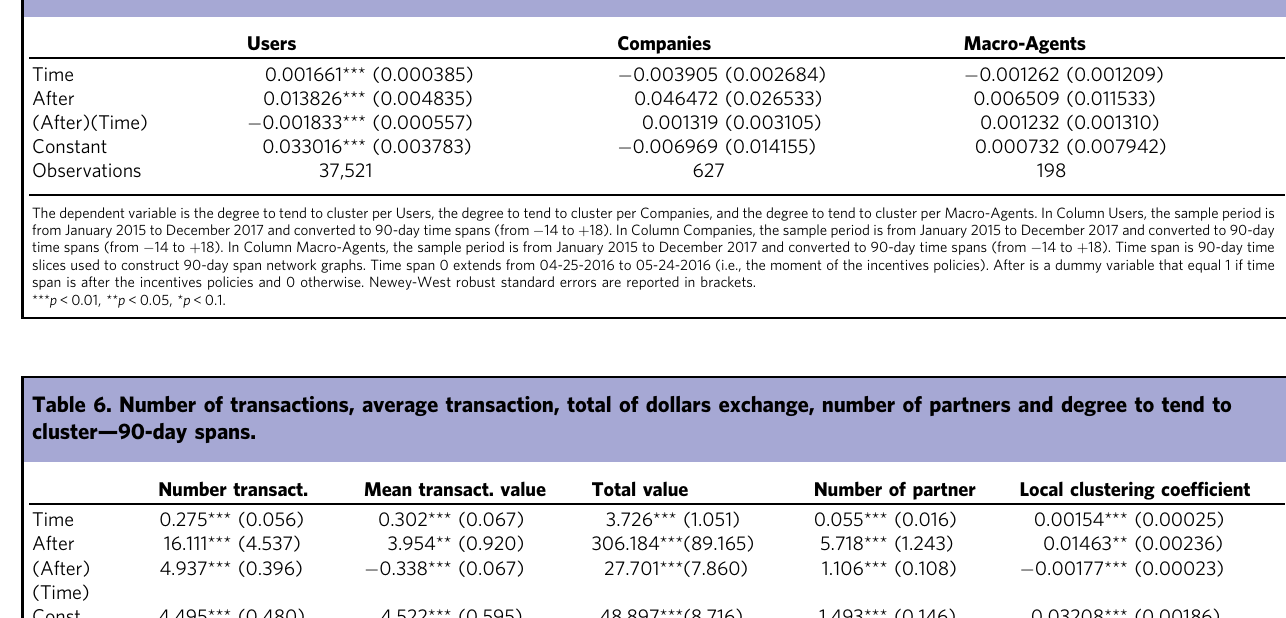
Table 5. Degree to tend to cluster — 90-day spans.